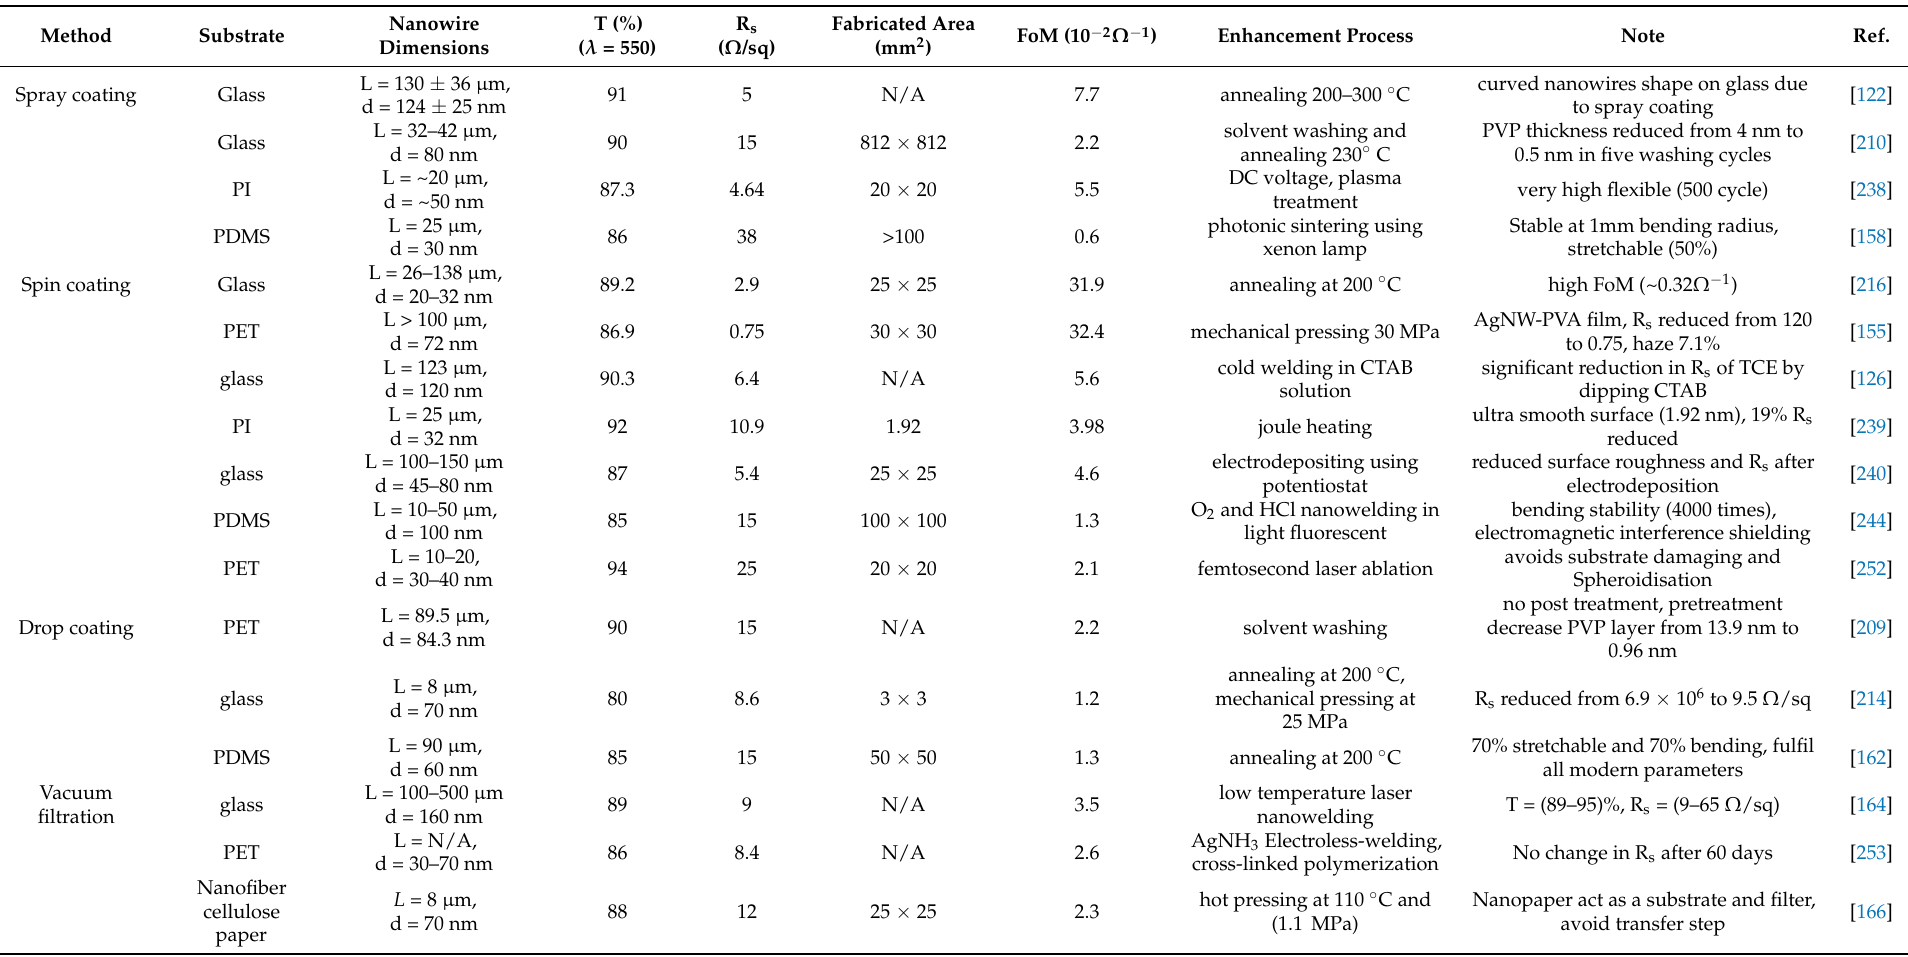
Table 2. Summarized TCE fabrication and treatment method along with their comparison using FoM (Haacke’s